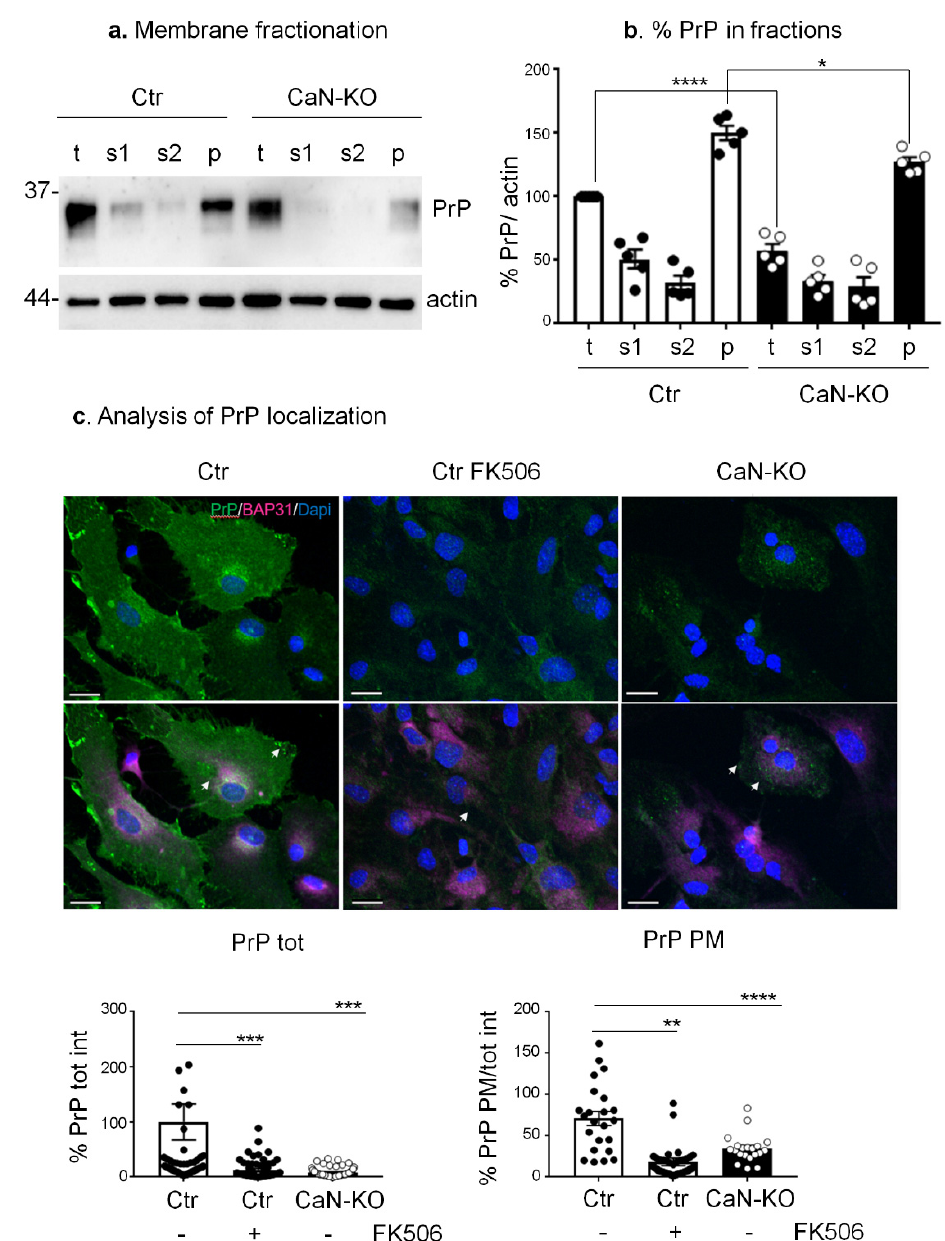
Figure 2. Analysis of PrP C localization in Ctr, FK506-treated Ctr and CaN-KO primary hippocampal astrocytes. ( a ) Fractionation of Ctr and CaN-KO astrocytic lysates by centrifugation and evaluation of PrP C relative abundance by WB with anti-PrP in t (total cell lysates), s1 (post nuclear supernatant), s2 (soluble fraction), p (membrane fraction) fractions. ( b ) Quantification of membrane fractionation is expressed as means ± SEM, n = 5; **** p < 0.0001, * p < 0.05 by one-way Anova, Sidak’s multiple comparison. ( c ) Immunofluoresce analysis on Ctr, FK506-treated Ctr and CaN-KO astrocytes with anti-PrP (green), anti-BAP31 (pink) antibodies and reacted with DAPI to stain the nuclei (blue). Confocal microscope analysis, scale bar 20 µm. Quantification of total PrP (PrP tot) or plasma membrane PrP (PrP PM) fluorescence density expressed as percentages of Ctr from Ctr n = 54 cells, FK506-treated Ctr n = 67 and CaN-KO n = 70 cells, from four to five replicates, ** p < 0.01, *** p < 0.001 and **** p < 0.0001.